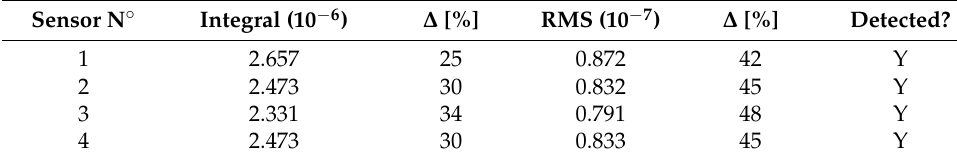
Figure 7. Scheme of void and IE device layout. Detected Y—Yes, N—No, W—Warning.